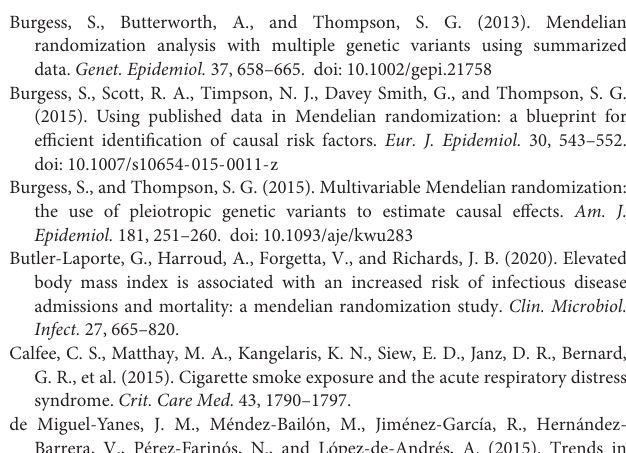
Supplementary Figure 1 | MR leave-one-out sensitivity analysis for “T2DM” on “sepsis”. MR, Mendelian randomization; T2DM, type 2 diabetes mellitus. Supplementary Figure 2 | MR leave-one-out sensitivity analysis for “T2DM” on “SSTI”. MR, Mendelian randomization; T2DM, type 2 diabetes mellitus; SSTI, skin and soft tissue infections. Supplementary Figure 3 | MR leave-one-out sensitivity analysis for “T2DM” on “UTI”. MR, Mendelian randomization; T2DM, type 2 diabetes mellitus; UTI, urinary tract infections. Supplementary Figure 4 | MR leave-one-out sensitivity analysis for “T2DM” on “pneumonia”. MR, Mendelian randomization; T2DM, type 2 diabetes mellitus. Supplementary Figure 5 | MR leave-one-out sensitivity analysis for “T2DM” on “GUI in pregnancy”. MR, Mendelian randomization; T2DM, type 2 diabetes mellitus; GUI, genito-urinary infection. Supplementary Table 1 | Characteristics of 137 genetic variants in T2DM and infections datasets. T2DM, type 2 diabetes mellitus; SNP, single-nucleotide polymorphism; Chr, chromosome; EA, effect allele; NEA, non-effect allele; SE, standard error; SSTI, skin and soft tissue infection; UTI, urinary tract infection; GUI, genito-urinary